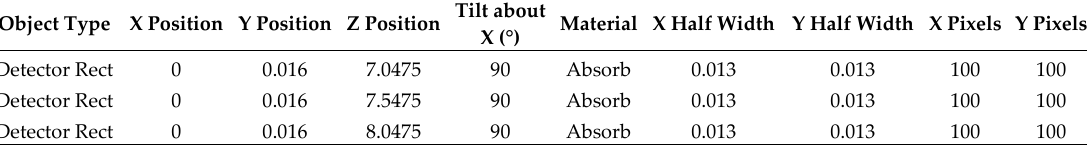
Table 3. Parameters used for the 3 detectors ( Zemax ® units—millimeters).